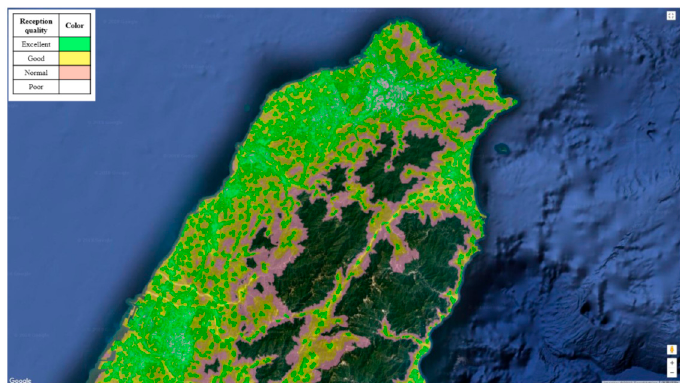
Figure 1. Signal coverage and reception quality of 3G/4G mobile phone networks.